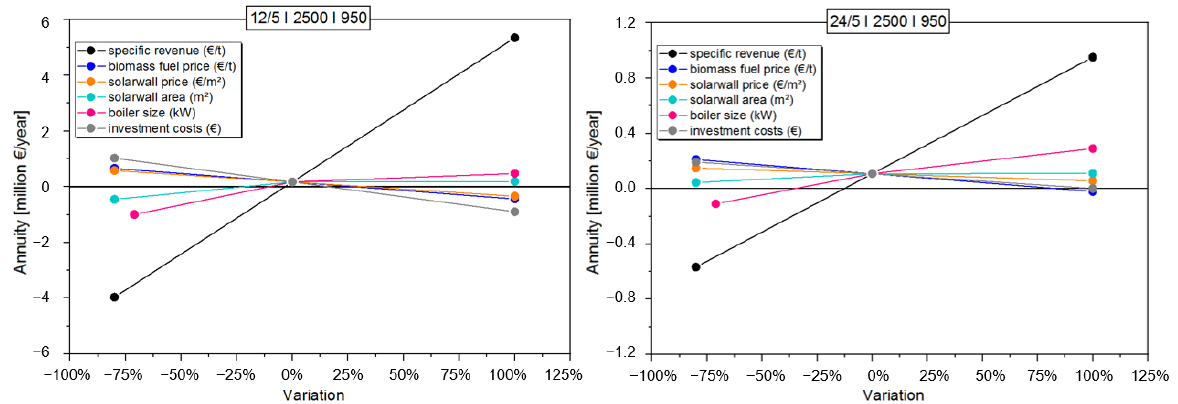
Figure 9. Results from the sensitivity analysis of the reference plant design for operational strategy 12/5 (12 h/d and five days per week, left ) and 24/5 (24 h/d and five days per week, right ). Table 8. Minimum, maximum, and break-even from the annuity calculation and sensitivity analysis of reference plant design (2500 m 2 , 950 kW) for both operational strategies 12/5 and 24/5.